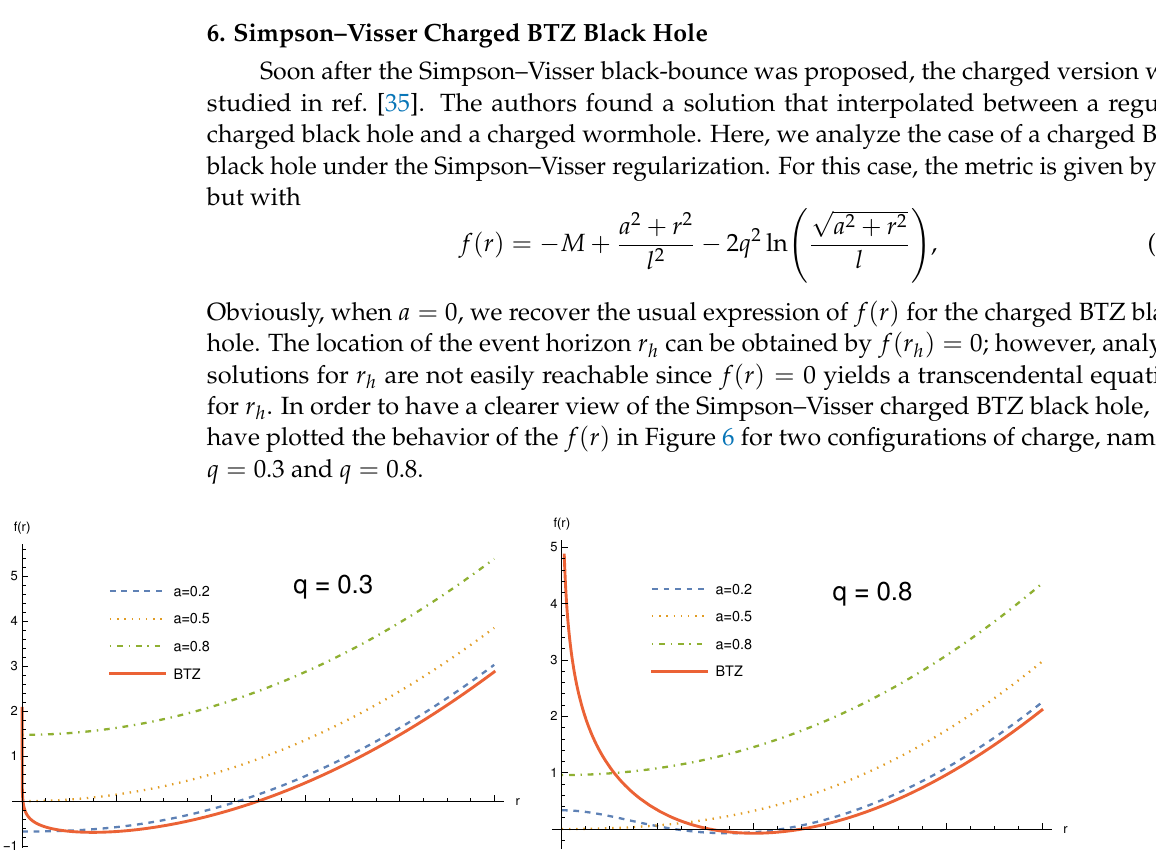
Figure 5. Effective potential ( a ) for massive particles and ( b ) for massless particles. For this plot, we used, l = 0.5, M = 1 and L = 0.1.